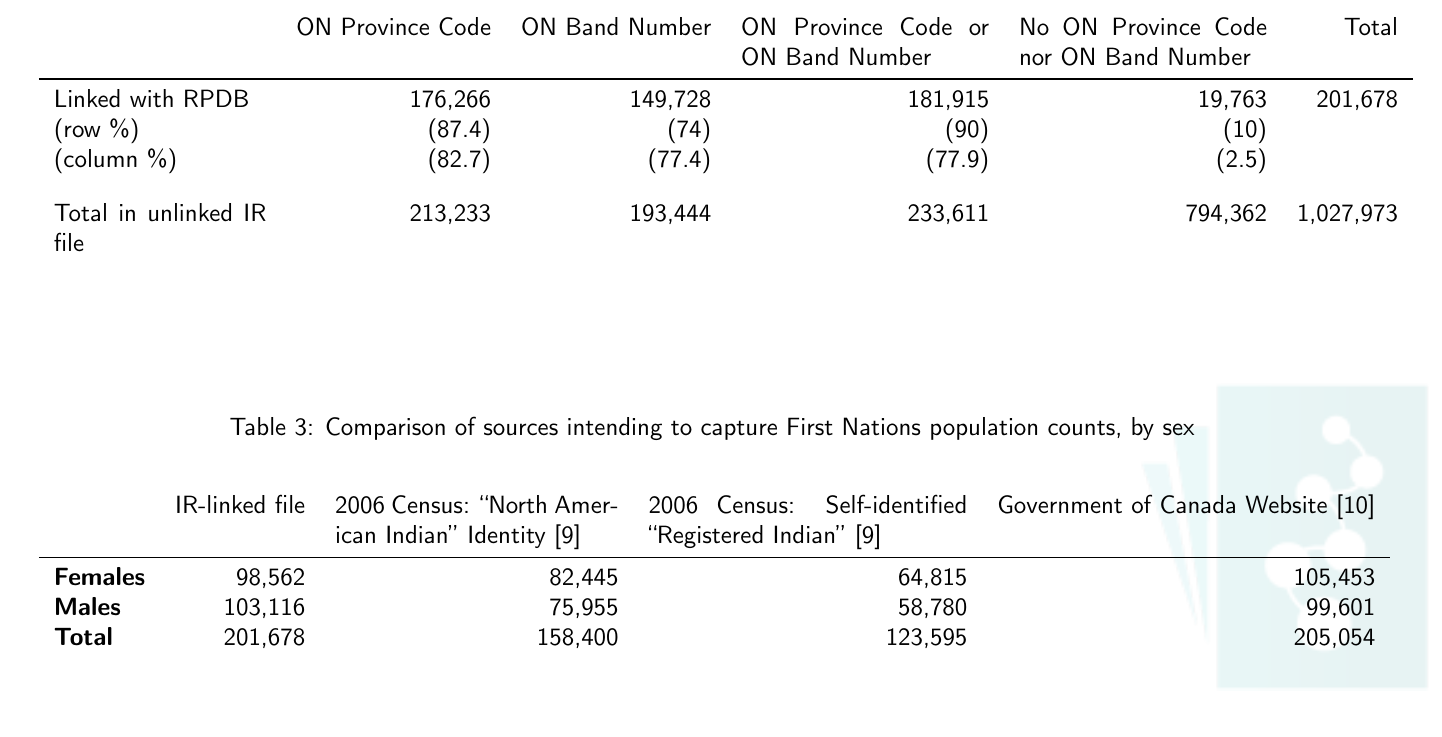
Table 2: Linkage results by Ontario band number and Ontario province code